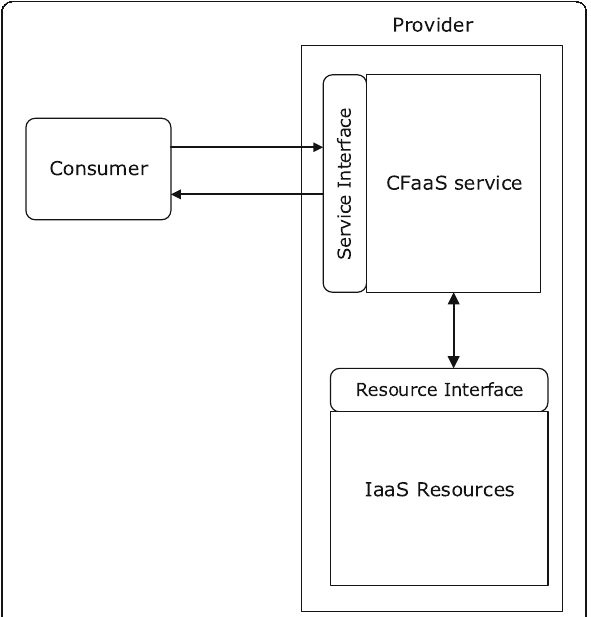
Fig. 3 Provider and Consumer of a cloud storage forensics